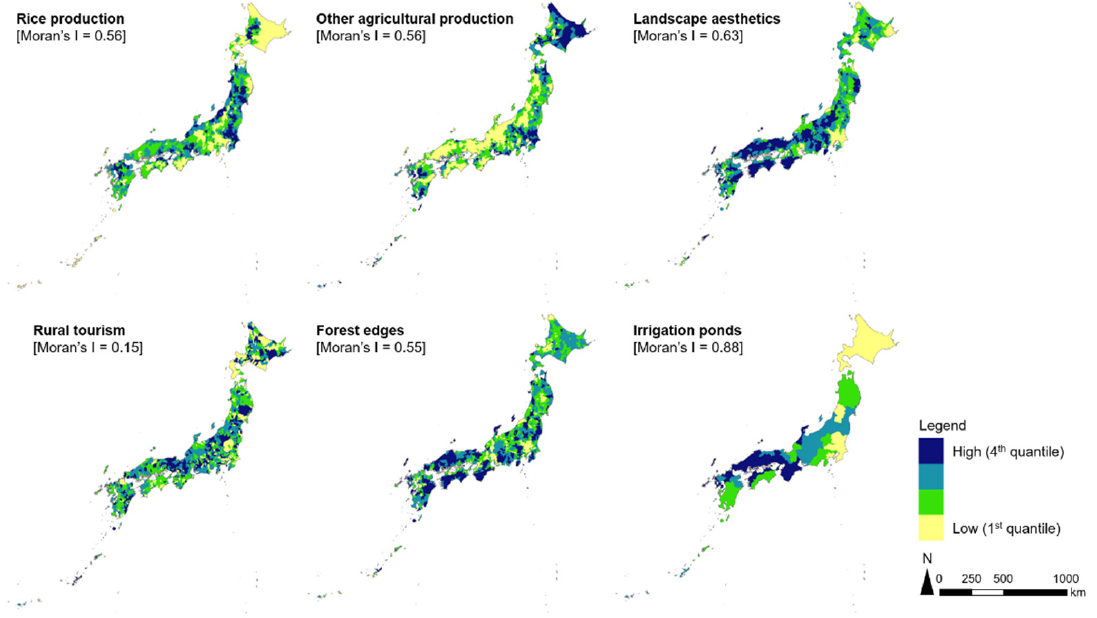
Figure 1. Spatial distributions of agricultural ecosystem services and farmland biodiversity in Japan at the municipal or prefectural level. Values are classified in quantiles. Moran’s I is all p < 0.001.